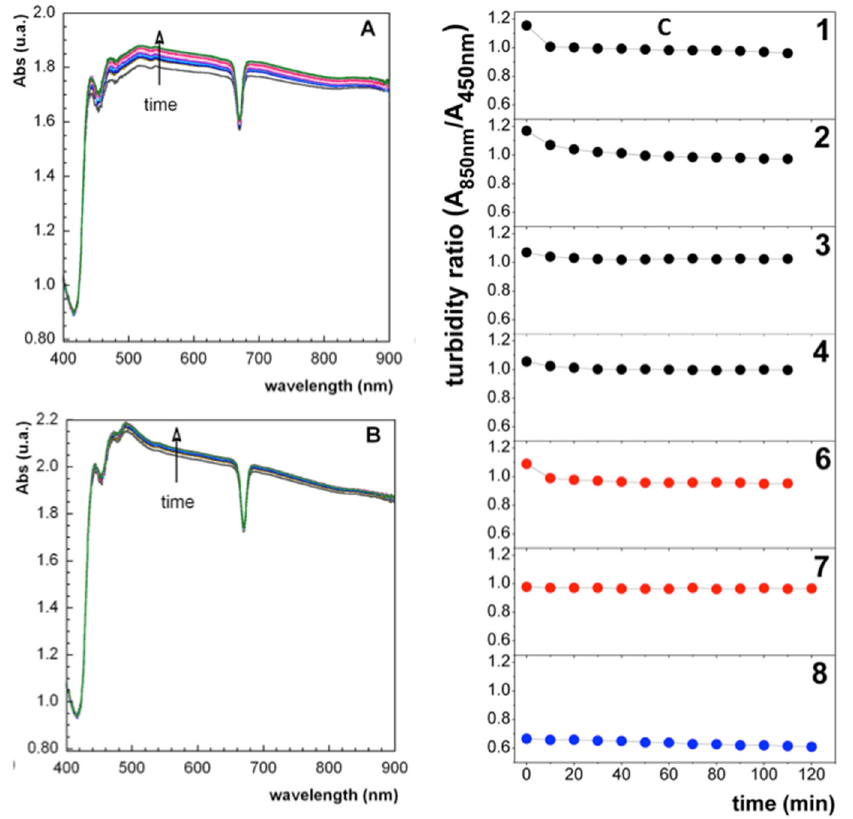
Figure 1. ( A ) turbidity spectra of w / o emulsions (sample 3) of Table 1; ( B ) turbidity spectra of sample 7 of Table 1; ( C ) turbidity ratio (A 850 nm / A 450 nm ) as a function of time. Panels from 1 to 4 refer to emulsion prepared with E471 as emulsifier, according to the compositions reported in Table 1. Panels 6–7 are relative to samples prepared using Span 80 at concentrations 0.5% and 1.0%, respectively . Panel 8 is relative to emulsion prepared with Span 80 and Tween 80.